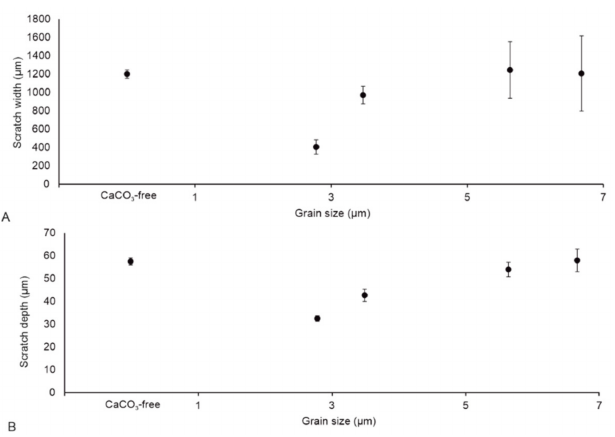
Figure 5. Scratch width w ( A ) and scratch depth d ( B ) values versus grain size of CaCO 3 particles for scratch surfaces after the scratch test.